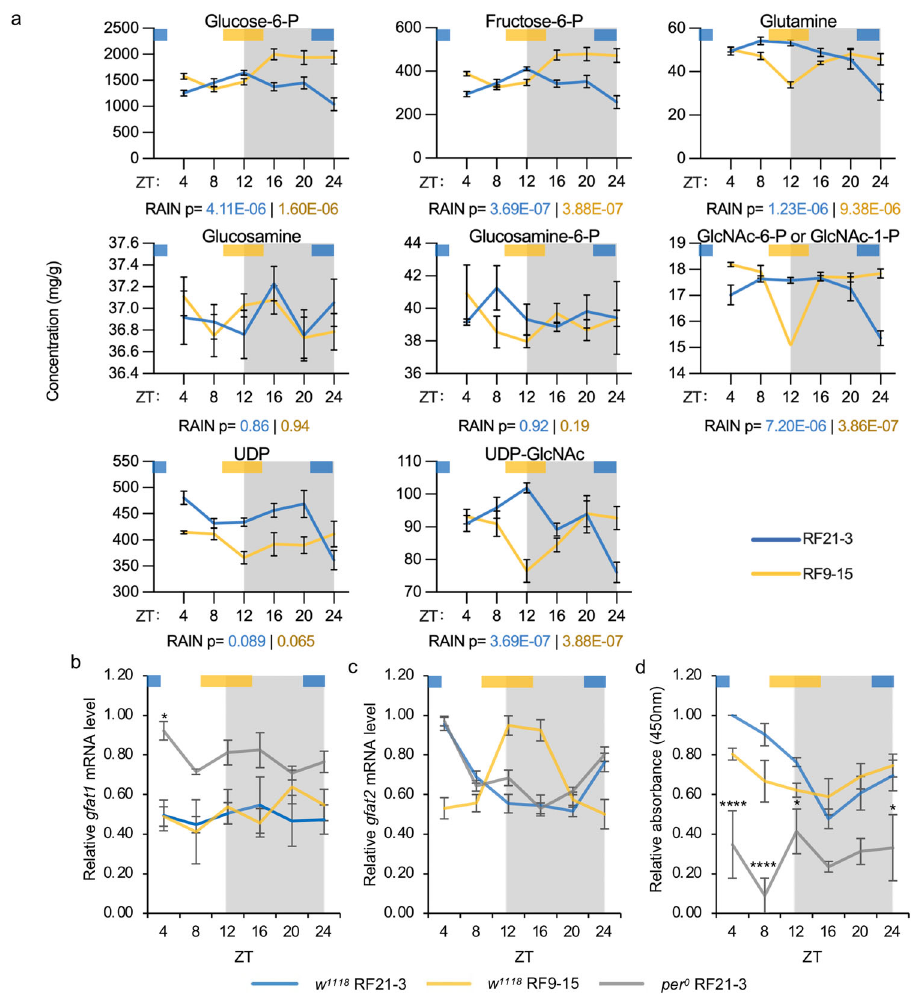
Fig. 4 Glutamine-fructose-6-phosphate aminotransferase (GFAT) is a key enzyme that is regulated by circadian clock. a Line graphs showing daily rhythms of HBP metabolites detected by targeted metabolomics in WT ( w 1118 ) fl ies fed between ZT21-3 (blue) or ZT9-15 (yellow) ( n = 6; p values from RAIN analysis are presented under each graph). Data were presented as mean ± SEM. b , c Expression of gfat1 and gfat2 mRNA in three groups of fl ies: WT RF21-3, per 0 RF21-3, and WT RF9-15. ( n = 3; gfat1 mRNA: WT RF21-3: p = 0.73, WT RF9-15: p = 0.59, per 0 RF21-3: p = 0.76; gfat2 mRNA: WT RF21-3: p = 1.58E − 05, WT RF9-15: p = 0.00019, per 0 RF21-3: p = 3.89E − 06, RAIN); ( gfat2 mRNA: WT vs per 0 RF21-3: mesor p = 0.23, amplitude p = 0.53, phase p = 0.66; WT RF21-3 vs RF9-15: mesor p = 0.95, amplitude p = 0.40, phase p = 1.12E − 12; CircaCompare). d Line graph representing daily GFAT enzymatic activity in WT ( w 1118 ) fl ies fed between ZT21-3 or ZT9-15 and per 0 fl ies fed between ZT21-3 ( n = 3; WT RF21-3: p = 5.73E − 07, WT RF9-15: p = 0.041, per 0 RF21-3: p = 0.92, RAIN; WT RF21-3 vs RF9-15: mesor p = 0.14, amplitude p = 0.01, phase p = 0.027, CircaCompare). b – d Data are presented as mean ± SEM. Gray shading indicates the dark period of LD cycle. Colored bars at the top of graphs denote the feeding periods for TRF treatment groups, RF21-3 (blue) and RF9-15 (yellow). The asterisks denote the comparison between WT RF21-3 and per 0 RF21-3 using two-way ANOVA with post-hoc Tukey ’ s HSD tests. * p < 0.05, **** p <